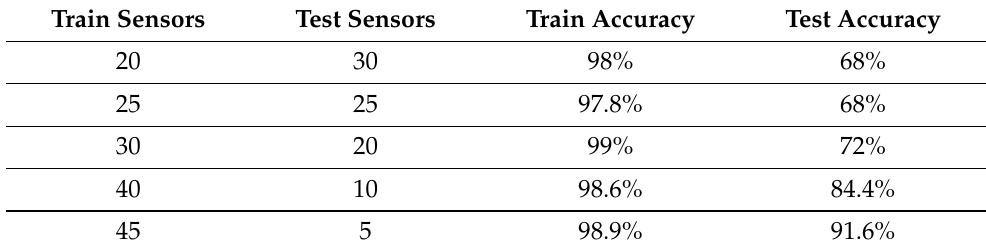
Table 3. DNN with different training and testing datasets.